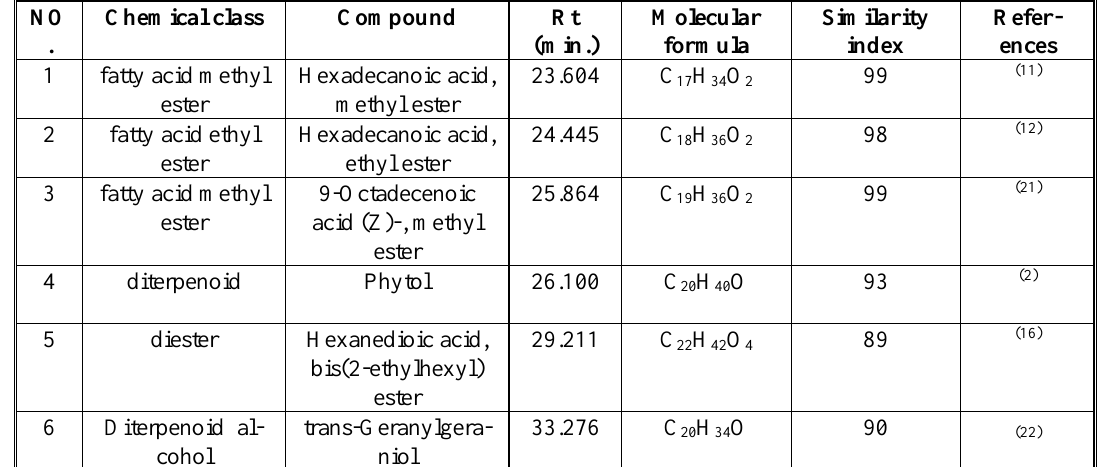
Figure 6. GC-MS analysis of petroleum ether stems extract of Leucaena leucocephala by cold extraction method.